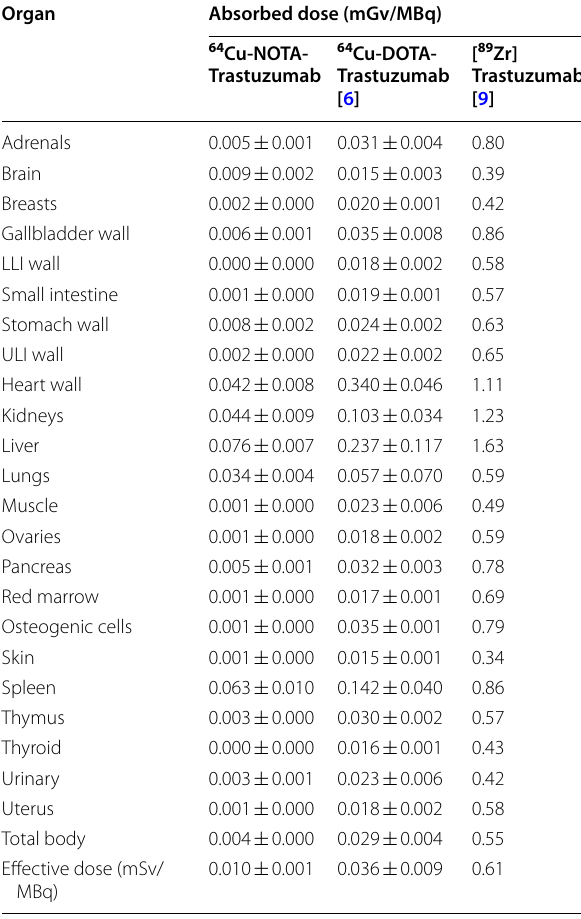
Table 2 Dosimetry of 64 Cu-NOTA-Trastuzumab